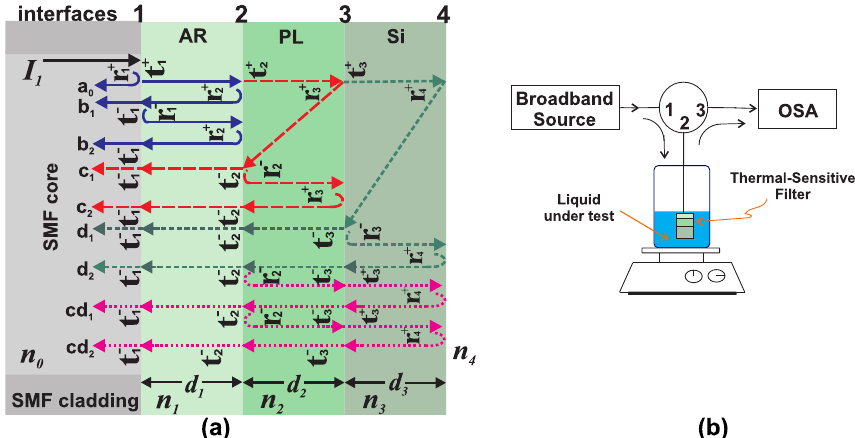
Figure 1. ( a ) Sketch of the reflected and transmitted waves occurring at each interface of the tunable FP filter; ( b ) sensing optical